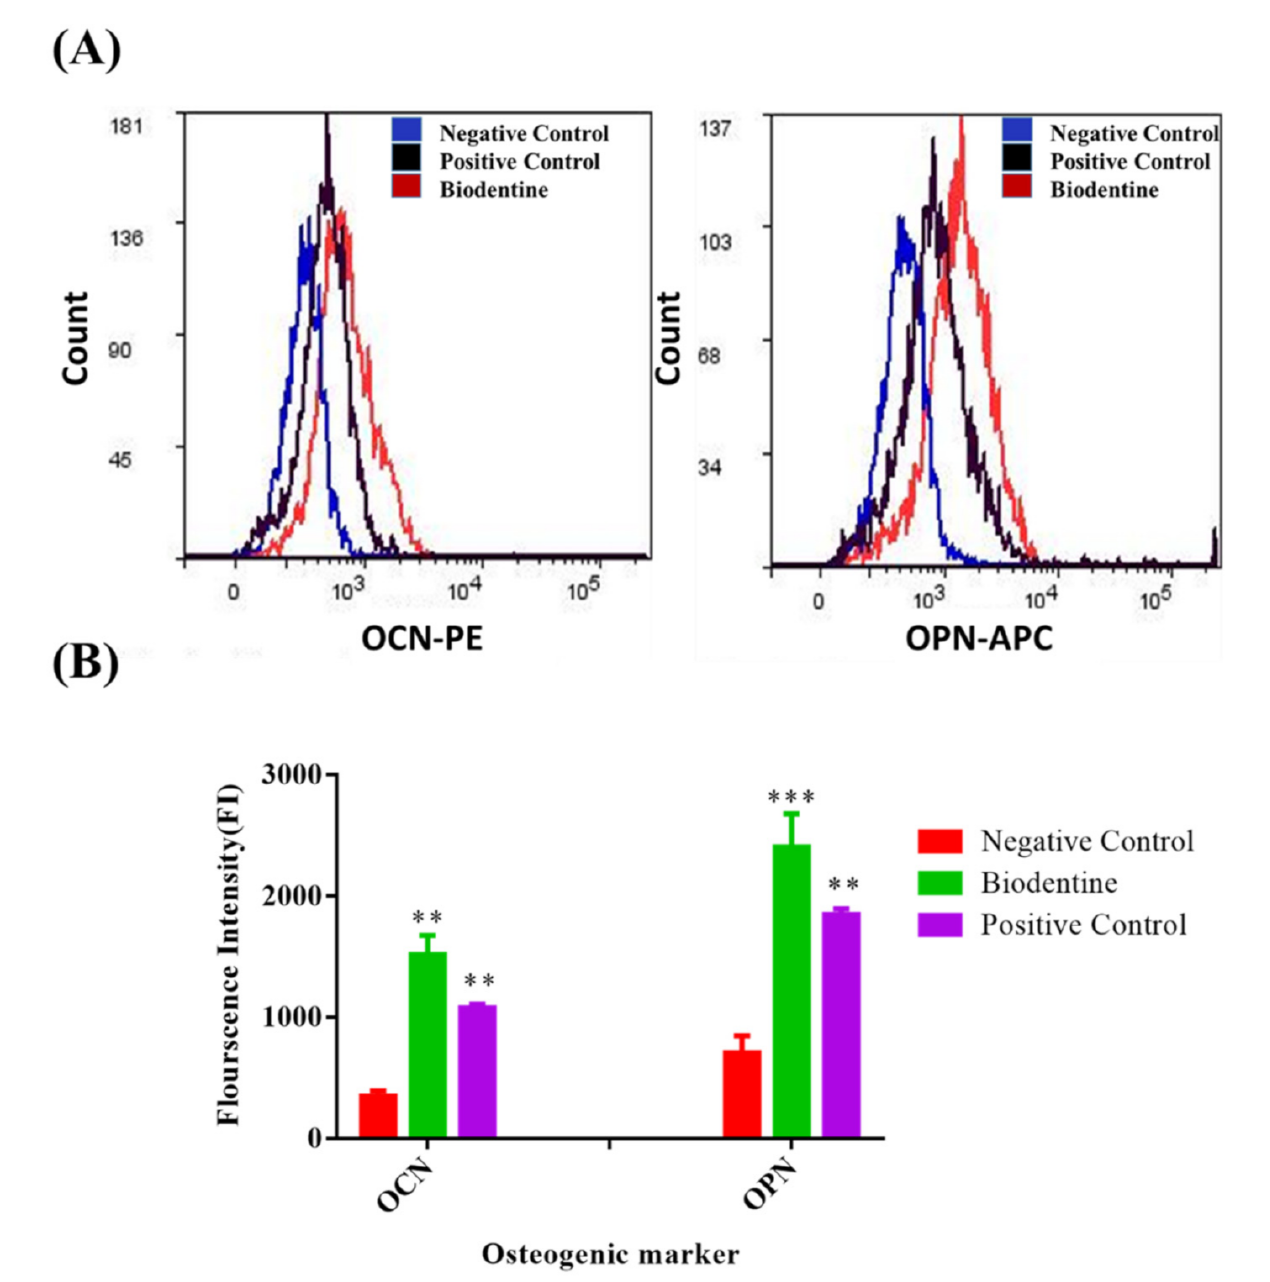
Figure 4. Flow cytometric results of the odonto/osteogenic differentiation markers. ( A ) Flow cytometric histograms, and ( B ) the statistical analysis of the Mean fluorescence Intensity (MFI) of flow cytometric results of the expression level of odonto/osteogenic markers; Osteocalcin (OCN) and Ostepontin (OPN), hDPSCs treated with: Biodentine, osteogenic differentiation media (positive control), compared to the uninduced cells cultured in their own growth media (negative control), after 3 weeks of treatment by flow cytometry. ( *** p < 0.0005, ** p <